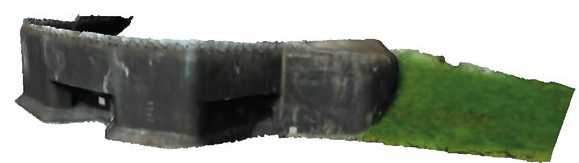
Fig. 5. 3D model MO-S 18